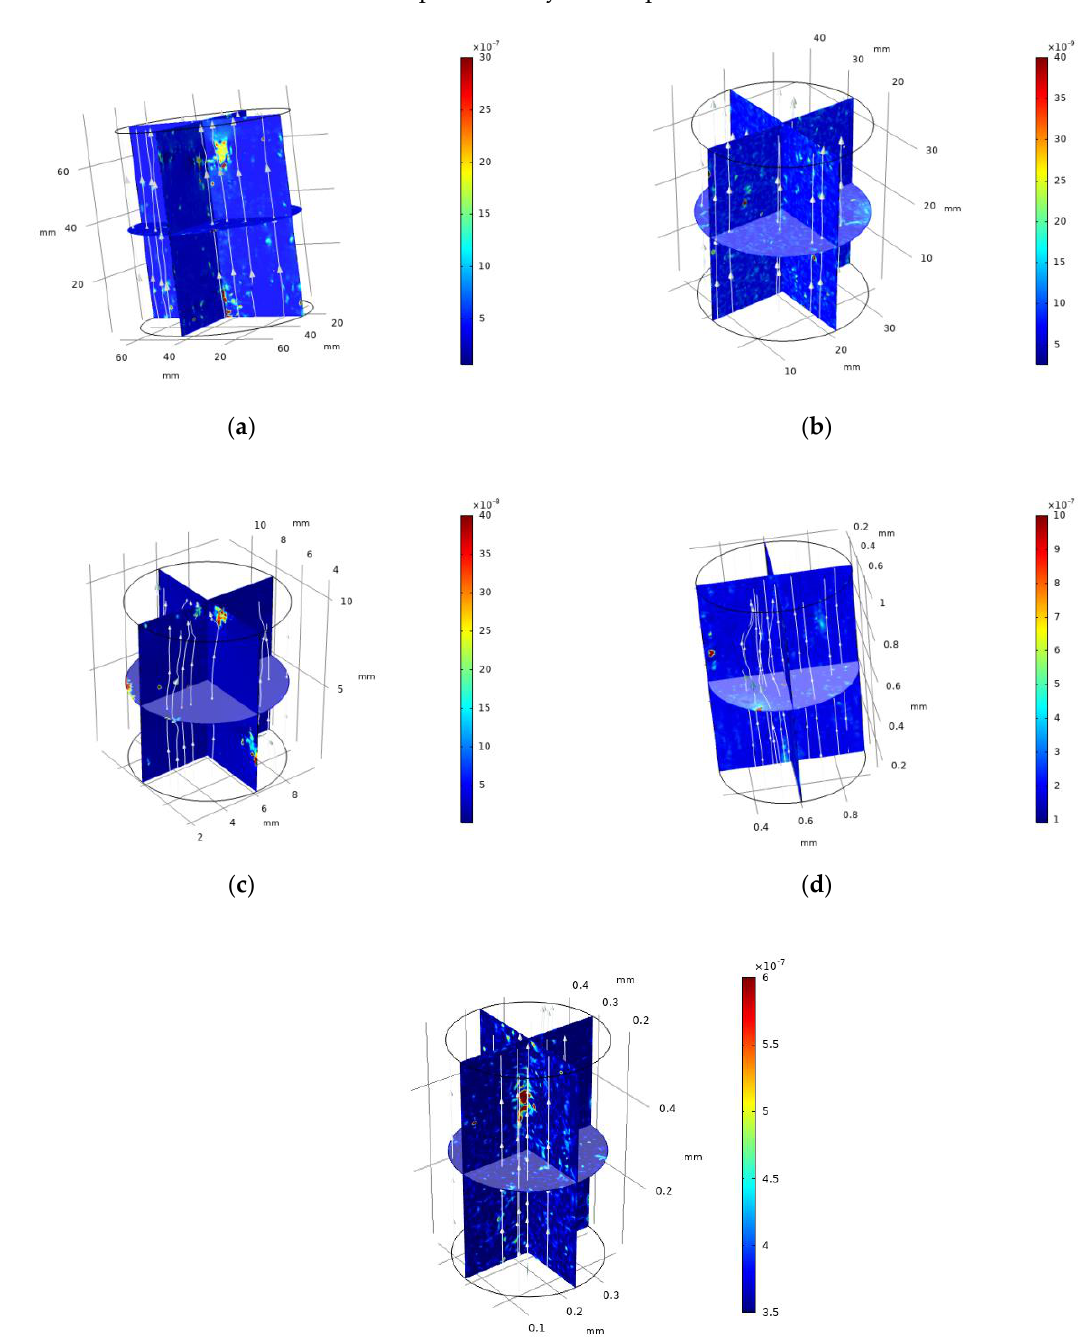
Figure 12. Velocity distribution (unit: m/s). ( a ) Sample C1; ( b ) Sample C2; ( c ) Sample C3; ( d ) Sample C4; ( e ) Sample C5